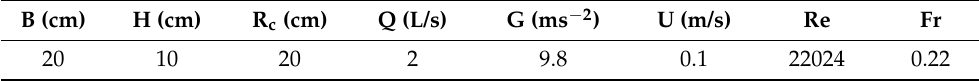
Table 1. Hydraulic characteristics of main flow in bend.